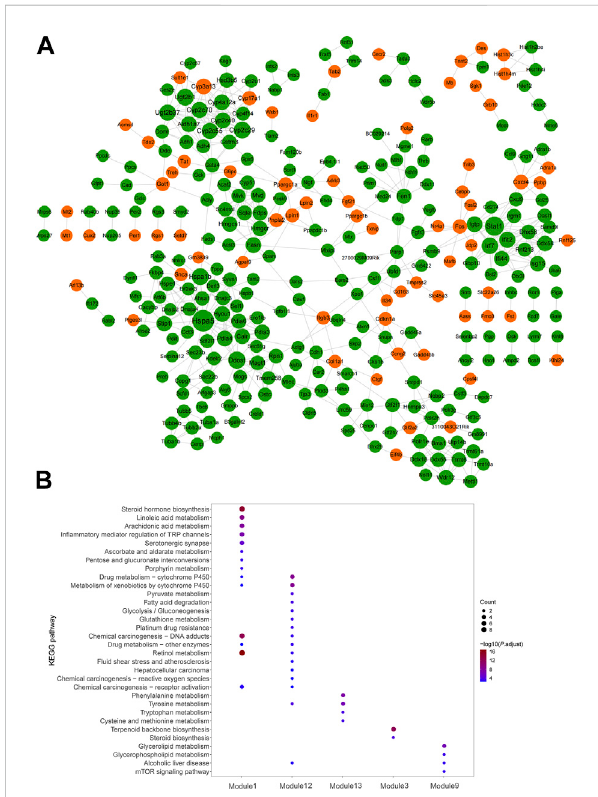
FIGURE 6 PPInetworkofdysregulatedmRNAsinsigni fi cantmRNAclusters. (A) PPI network predicted the interaction between proteins encoded by down-up/up-down mRNAs in the Fed – Fast – Refed cycle. The orange proteins encoded by dysregulated mRNAs were upregulated and subsequently downregulated in the Fed – Fast – Refed cycle. The green proteins encoded by dysregulated mRNAs were downregulated and subsequently upregulated in the Fed – Fast – Refed cycle. The node size shows the degree of connection. The grey line showsinteractionbetweenproteinsencodedbythesemRNAs. (B) Key modules were enriched in a series of KEGG pathways related to